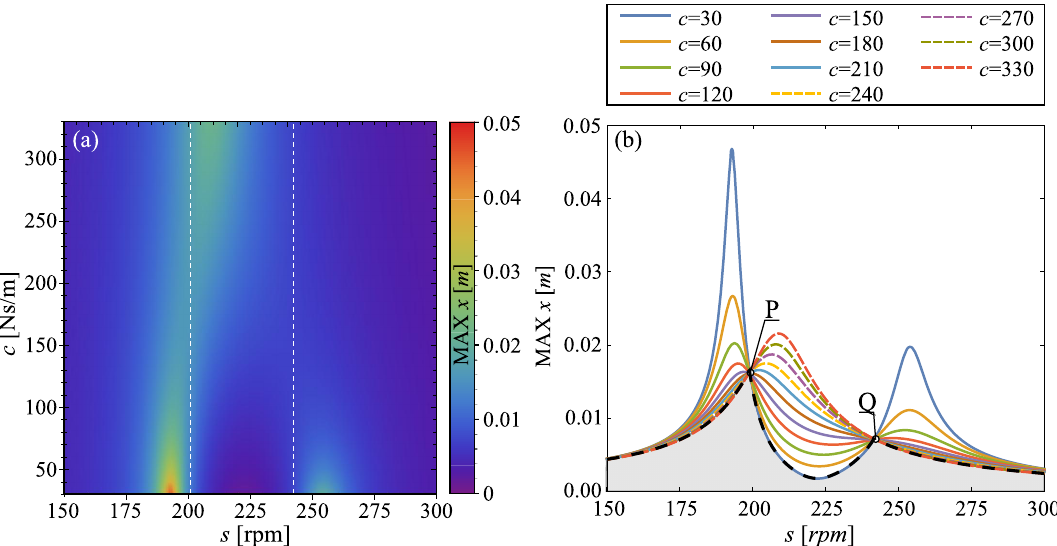
Figure 2. Effectiveness of strategy 0. The plot shows the influence of damping coefficient value on the response of the system. In panel ( a ) we show two dimensional plot of maximum amplitude of damped system (max x [ m ] ) in two parameters of space: a and s . The panel ( b ) refers to eleven exemplary FRCs of the damped